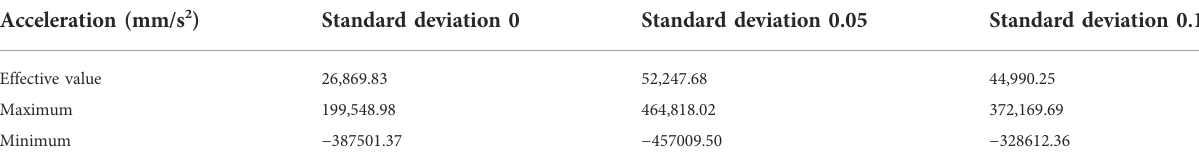
TABLE 4 Acceleration values under different particle